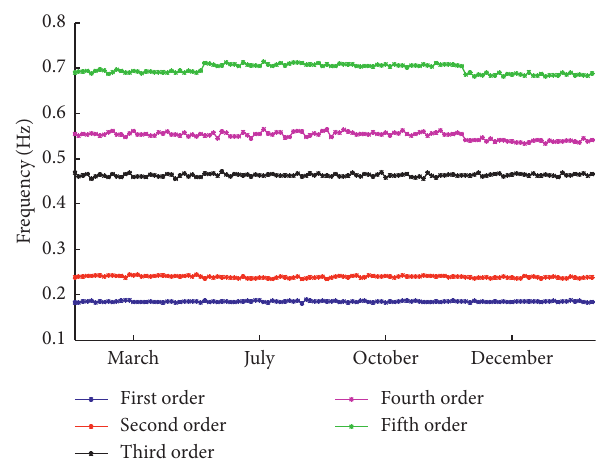
Figure 21: Frequency value trends for the top five